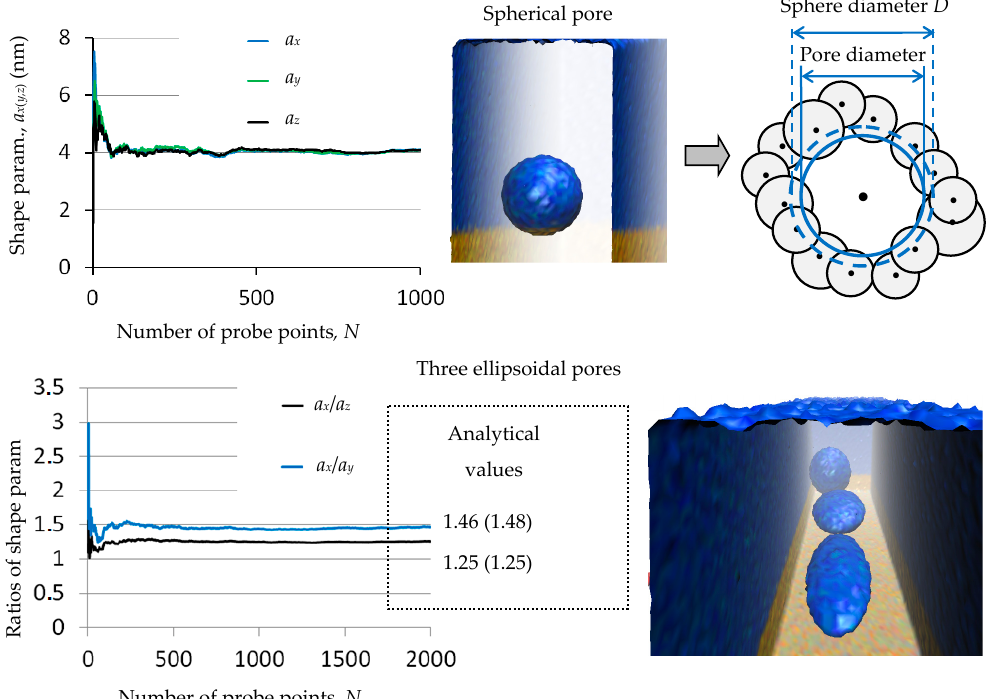
Figure 5. Result of the shape parameters calculations for the model problems. The convergence of the calculated values with an increase in the number of probe points is shown. The analytical and simulation values of shape parameters ratios coincide. The shape of the pores is shown on the right part of the figure.